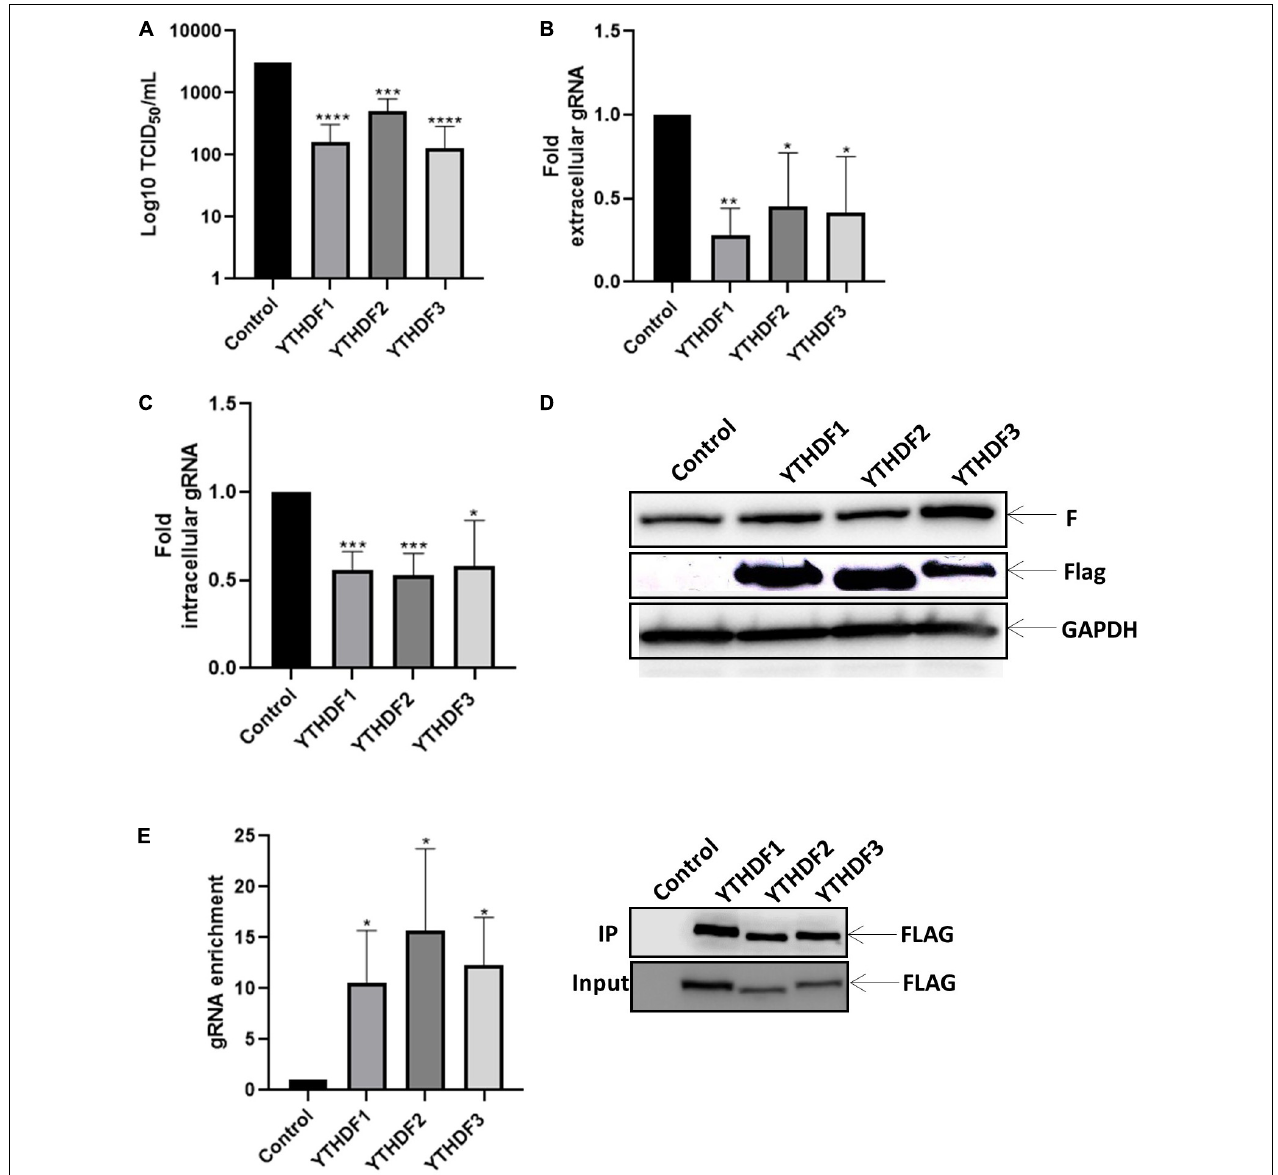
FIGURE 3 | YTHDF proteins bind to the gRNA and disadvantage the synthesis of gRNA along with viral replication. HEK293T cells were transfected with the vector expressing YTHDF1-3 and, the control vector expressing d2EGFP. Then the cells were infected with HRSV at MOI:1 for 24 h. (A) The supernatant was extracted, and the infectious titer was analyzed by the TCID 50 assay. (B) The extracellular and (C) intracellular gRNA was quantified by RT-qPCR. Results were normalized vs. control (arbitrary set to 1) and expressed as the mean ± SD of three independent experiment. (D) Cell lysates from infected cells were used for the detection of the F protein and Flag-tagged proteins by Western blot. GAPDH was used as a loading control. (E) Enrichment of gRNA by immunoprecipitation anti-Flag from cell extracts. gRNA was quantified by RT-qPCR and the fold of enrichment was graphed in relation to the control. The data are representative of three independent experiments (* p < 0.05; ** p < 0.01; *** p < 0.001; **** p < 0.0001; ns, not